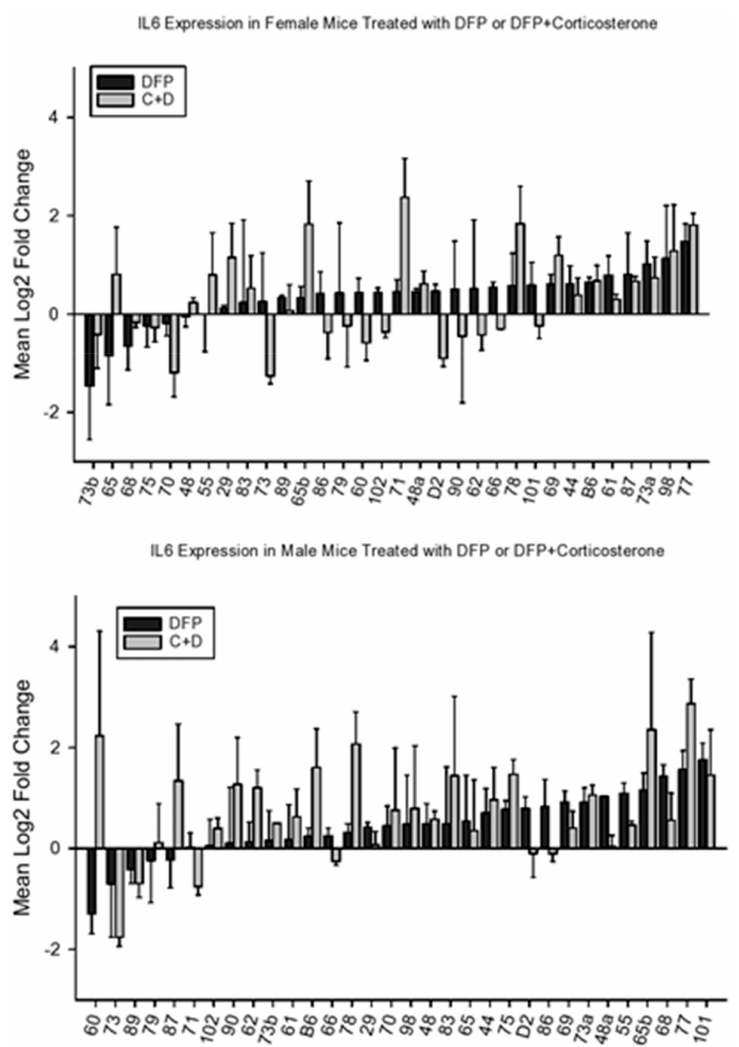
Figure 5. Mean change ( ± s.e.m) vs. control in Il6 expression in prefrontal cortex 6 h following intraperitoneal injection with diisopropylflurophosphate (4 mg / kg—black bars) or 7 days of corticosterone in the drinking water and 6h following intraperiteoneal injection with diisopropylflurophosphate (gray bars). Top panel, females, bottom panel,